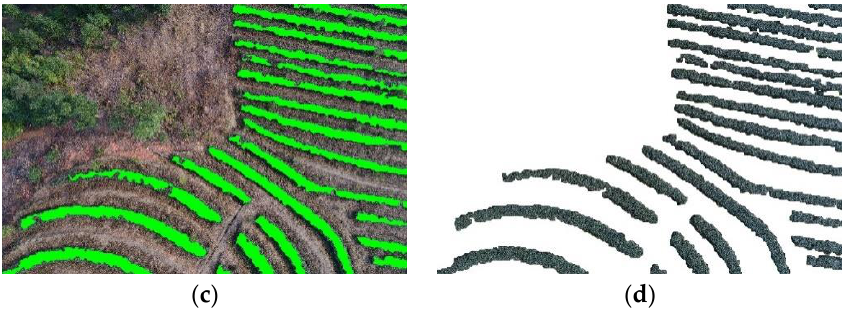
Figure 14. KNN classification and tea tree extraction. ( a ) Mean shift clustering results; ( b ) KNN classification results; ( c ) contour fitting result; and ( d ) extraction results. After extracting the tea trees from the images, we utilized Photoshop software to artificially extract the tea tree pixels from the tea garden image as the ground truth. The comparison between the ground truth and method performed in this study are shown in Figure 15. The green pixels represent the correctly extracted part when the extracted pixels matched the ground truth; the red pixels represent the incorrectly extracted part when the extracted pixels did not match the ground truth; and the blue pixels represent the missed extracted part of the tea tree.